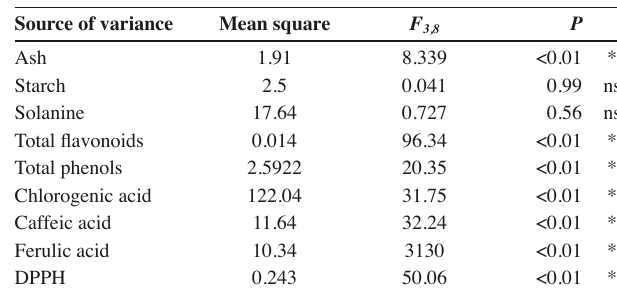
Tab. 4: One-way ANOVA results of potato genotype effect on phytochemical parameters. Key: *, significant ( P < 0.01); ns, not